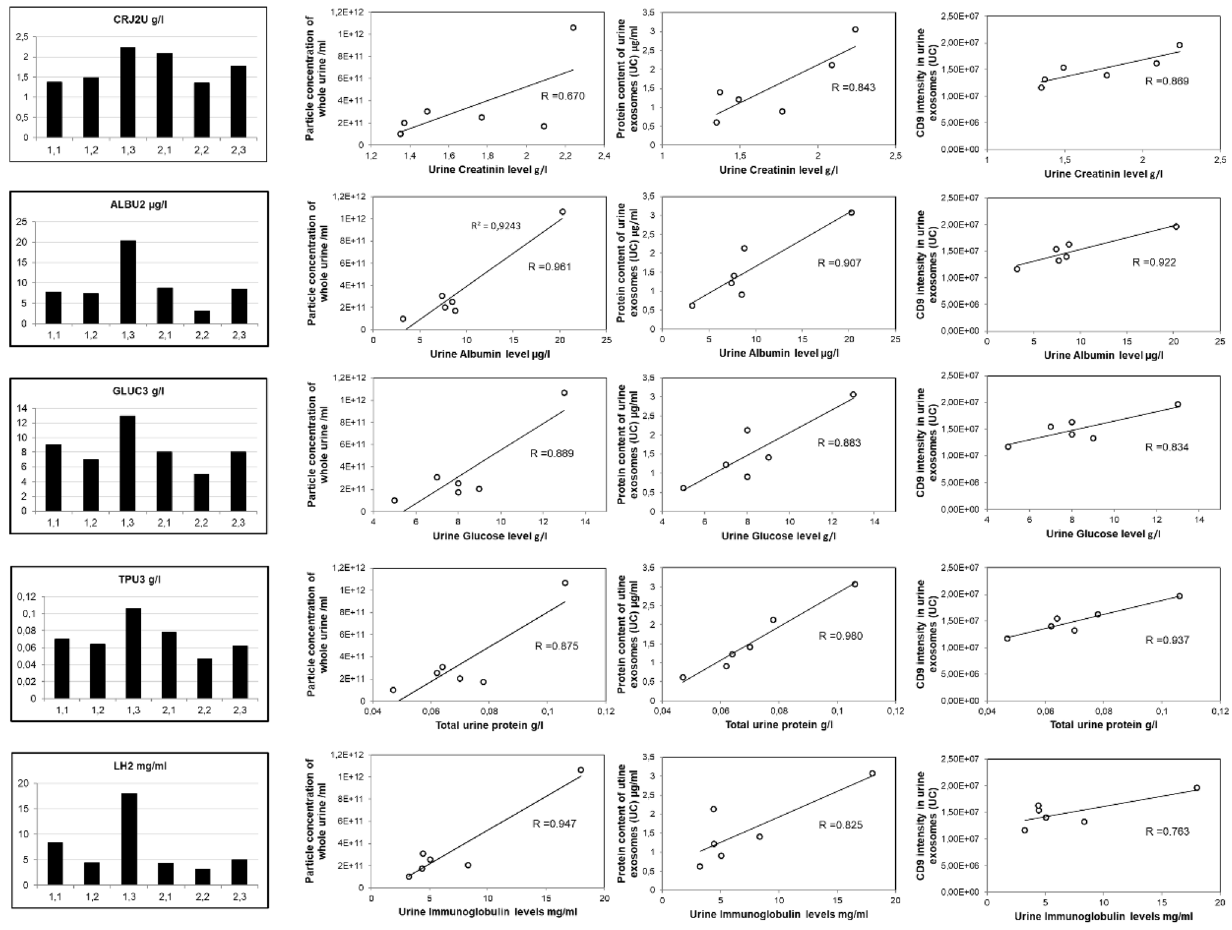
Figure 6. Analysis of urine biochemical parameters in longitudinal urine samples. Urine samples are obtained from urine obtained from two healthy volunteers, one female (marked as 1) and one male (marked as 2), 45 and 43 years old, in 3 subsequent days. These longitudinal urine samples were submitted to a routine biochemical urine analysis in a San Raffaele Hospital clinical laboratory within two hours from collection. Panels on the right show the correlation analysis performed by plotting the values of selected biochemical parameters against the EV parameters independently measured in the same urine samples. Explanation of acronyms used: CRJ2U, creatinine; ALBU2, albumin; GLUC3, glucose; TPU, total protein in urine; LH2, light immunoglobulin